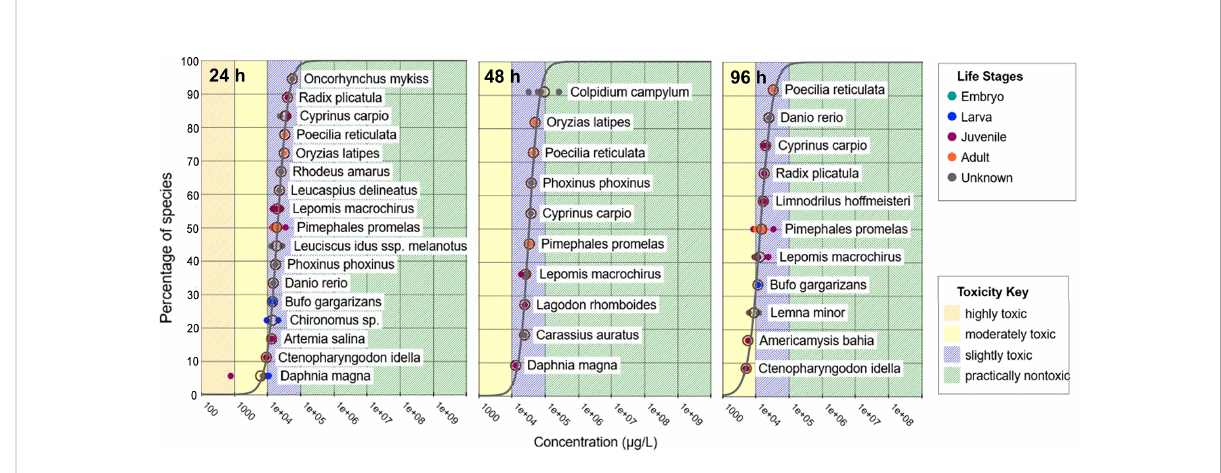
FIGURE 5 Species sensitivity distributions of ACN shown in aquatic effect module of CAFE ́